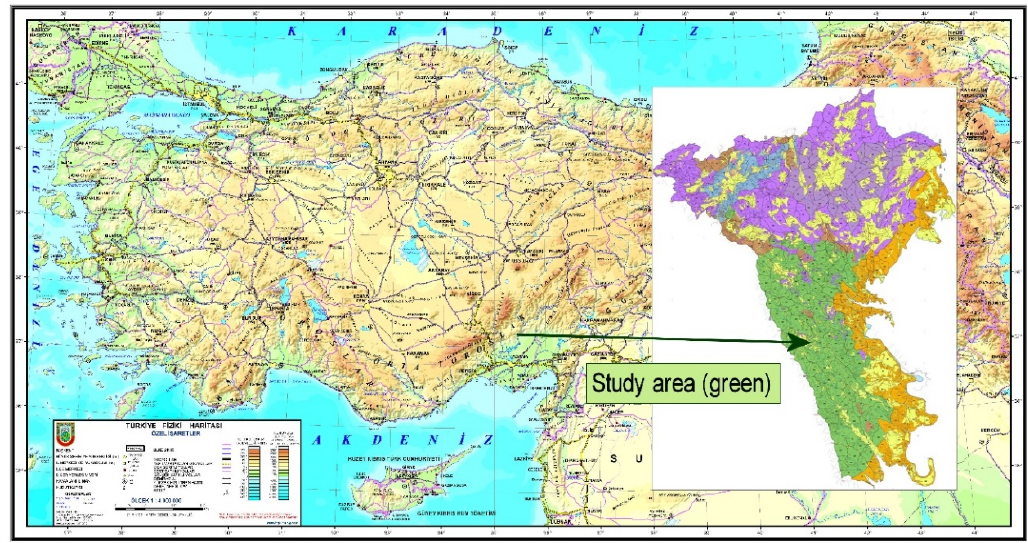
Figure 1. Location of the Akoren Planning Unit and the study area (Turkish pine working circle).